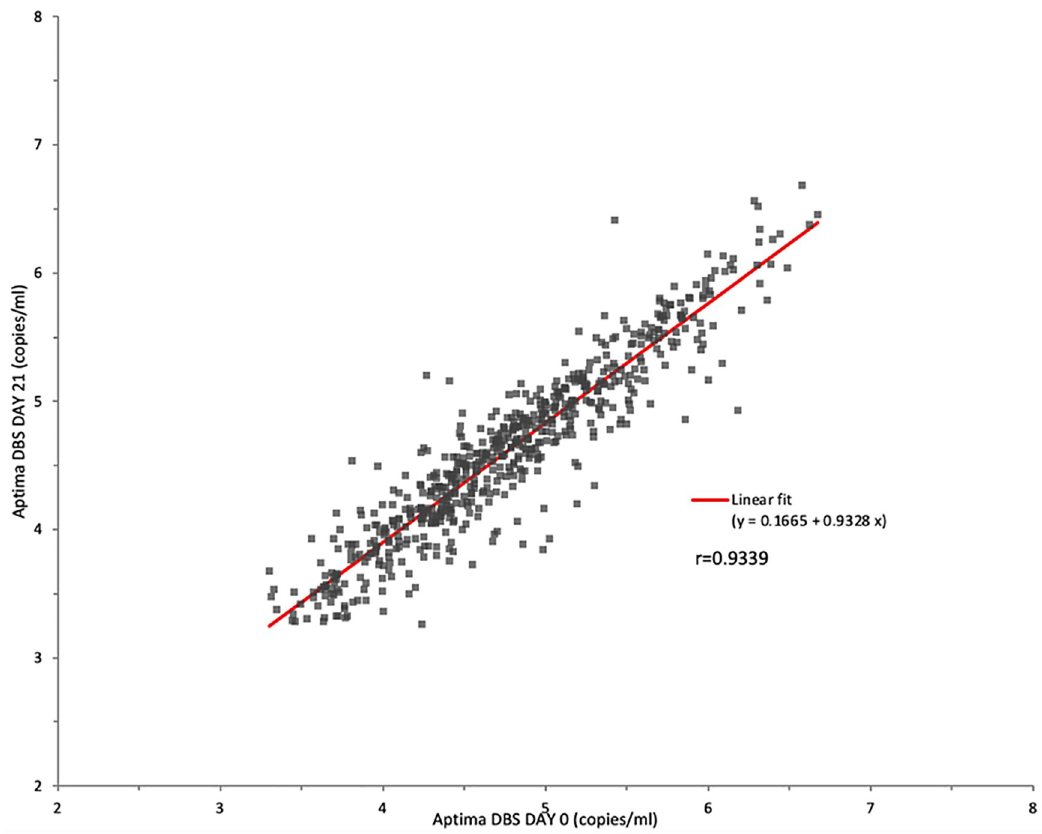
Fig 5. HIV VL in DBS tested on day 0 and day 21 in the Aptima assay.